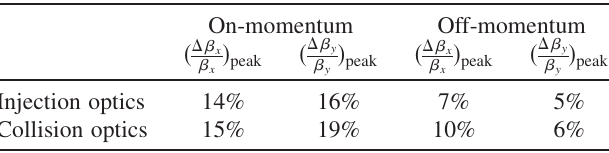
TABLE I. Relative peak beta-beating tolerances for the LHC as extracted from Ref. [1]. The off-momentum tolerances are given at the maximum momentum deviation of (cid:1) p ¼ 1 : 5 (cid:2) 10 (cid:1) 3 and (cid:1) p ¼ 0 : 86 (cid:2) 10 (cid:1) 3 for injection and collision optics, respec-